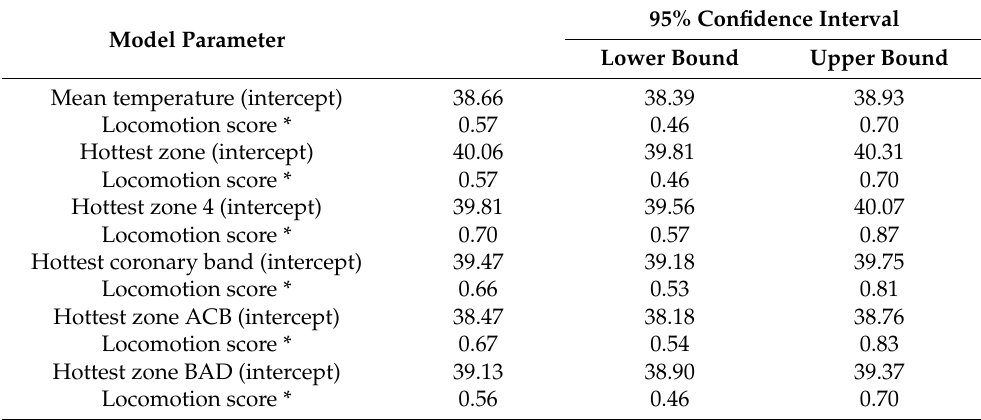
Table 7. Temperature measures estimates and their 95% confidence intervals on three dairy farms in Morogoro ( n = 170).